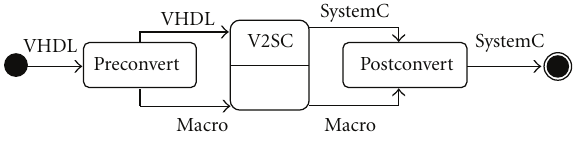
Figure 11: Normal distribution.